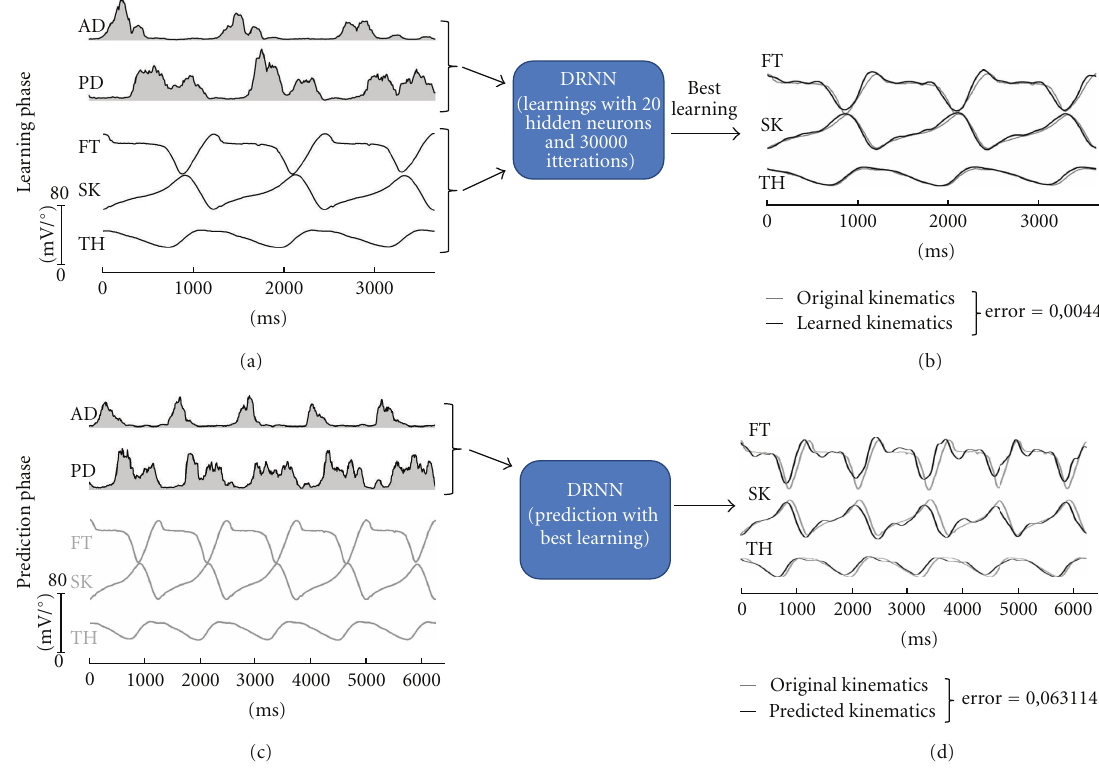
Figure 2: Kinematics of the lower limb predicted by a DRNN receiving shoulder muscles EMG signals. (a) During the learning phase, smoothed and rectified EMG signals of the anterior and posterior deltoid muscle (AD, PD) are used as input while the elevation angles of the feet (FT), the shank (SK), and the thigh (TH) are the desired outputs. (b) Superimposition of the real and simulated elevation angle curves. (c) During the prediction phase, unlearned EMG used as input to the DRNN. (d) Superimposition of the real and simulated elevation angle curves produced by unlearned EMG